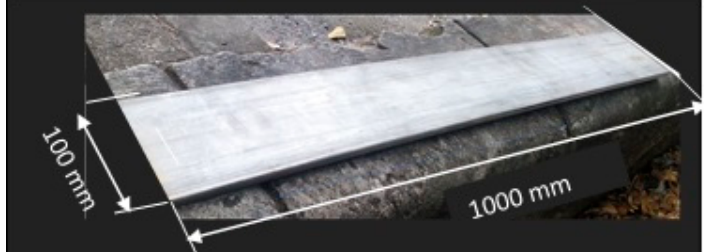
Table 1. Composition of AISI 304.